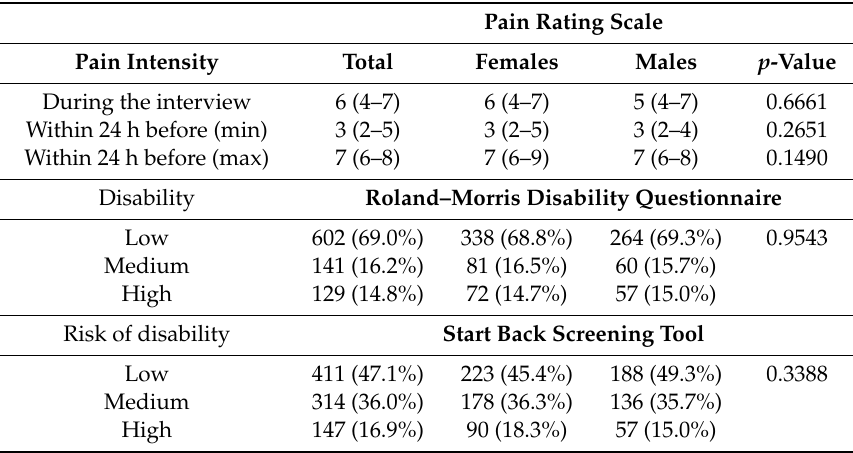
Table 2. The intensity of LBP based on a Pain Rating Scale (0: pain absence, 10 the worst pain possible), and patient distribution (No.; %) based on Roland and Morris Disability Questionnaire (RMDQ) and Start Back Screening Tool (SBST).